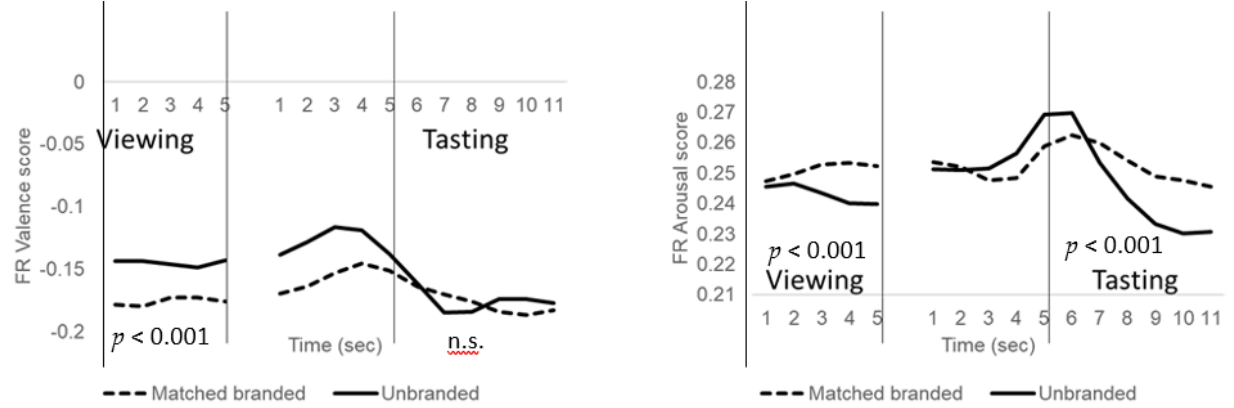
Figure 2. Facial expressions related to valence (left) and arousal (right) during 5 s of viewing, 5 s of anticipation between viewing and tasting, and 6 s of tasting (6–11 s) of unbranded (solid line) and matched branded (dashed line) stimuli. Results were averaged across participants and stimuli. Significance levels of branded/unbranded differences are indicated by p -values. N.s. = not